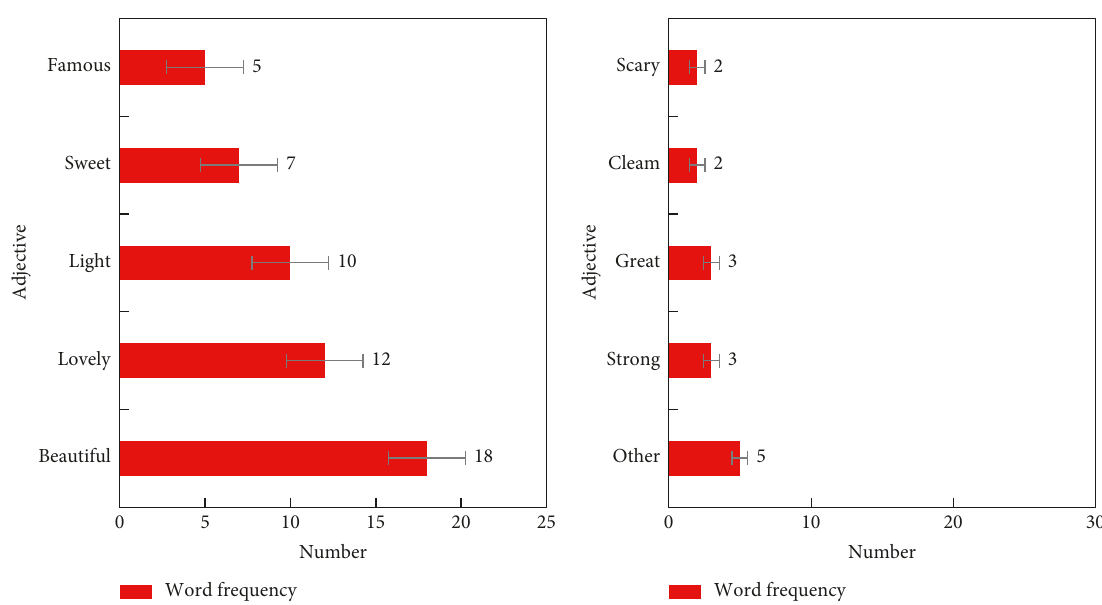
Figure 9: The emotional high-frequency words of Western inbound tourists to Shanghai.